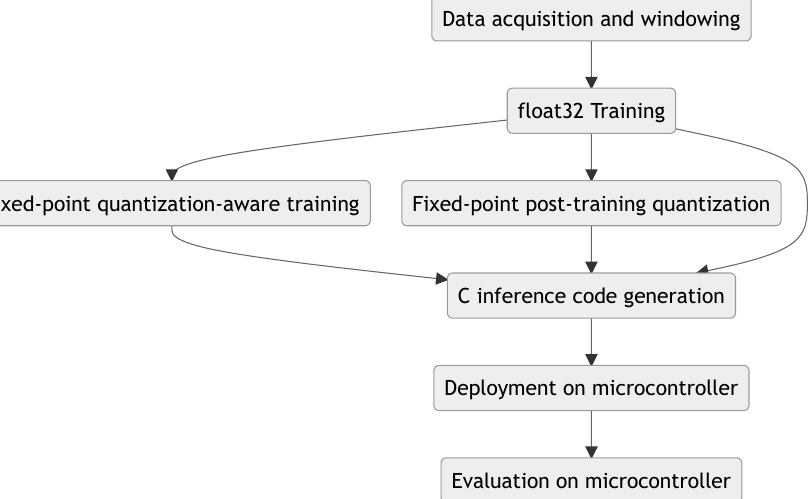
Figure 4. MicroAI general flow for neural network quantization and evaluation on embedded target